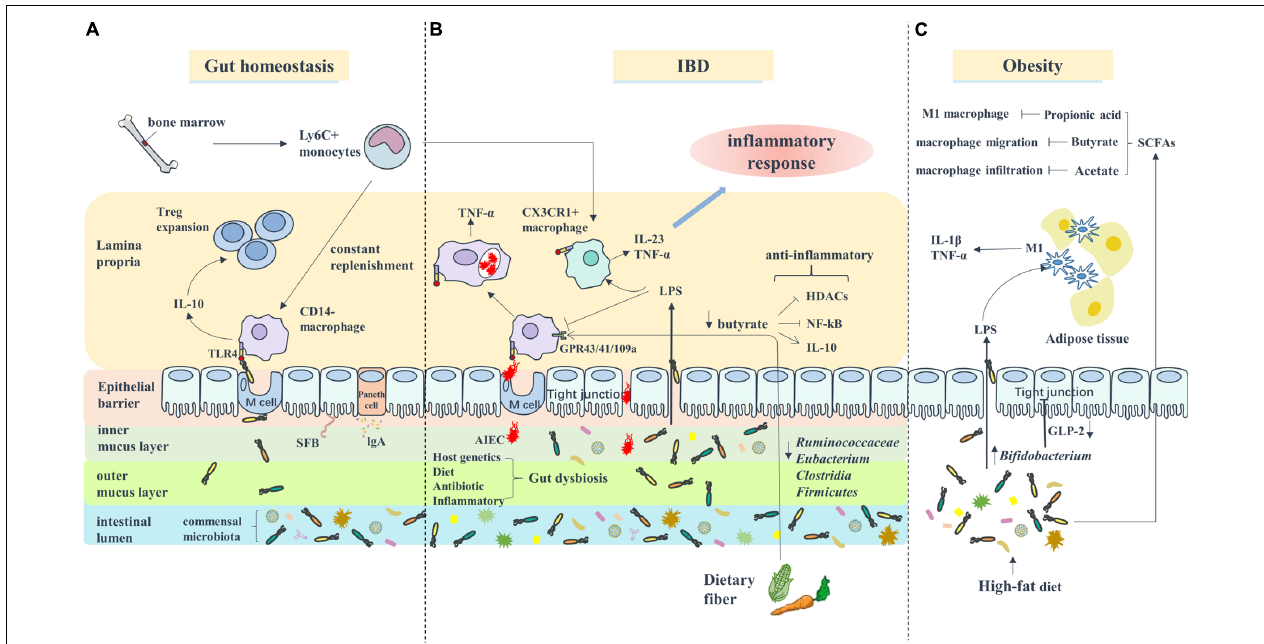
FIGURE 1 | Macrophages are involved in the interaction between gut microbiota and IBD or Obesity. (A) Under gut homeostasis, bone marrow derived Ly6C + monocytes are constantly recruited to gut to replenish the intestinal macrophages (CD14 − macrophages) which recognize the pathogen through TLR4 receptor and secret anti-inflammatory cytokine IL-10 to promote Treg cell expansion. (B) In IBD, the inflammatory environment lead to gut dysbiosis included increased number of AIEC which can survive and replicate in macrophages, and decreased butyrate bacteria like Ruminococcaceae , Eubacterium , Clostridia , and Firmicutes, which impairs the ability of butyrate exert anti-inflammatory role through inhibiting HDACs/NF- κ B (GPR43/41) or promoting IL-10 secretion (GPR109a). Additionally, blood Ly6C + monocytes are recruited to intestinal to become inflammatory macrophages (CX3CR1 + macrophages) and secrete pro-inflammatory cytokines such as IL-23 and TNF- α to participated in inflammatory response. (C) In Obesity, the alteration of gut microbiota composition caused by HFD-diet lead to an increase of intestinal permeability, therefore LPS enter system circulation (i.e., metabolic endotoxemia). Adipose tissue macrophages are response to LPS activation and transform to M1